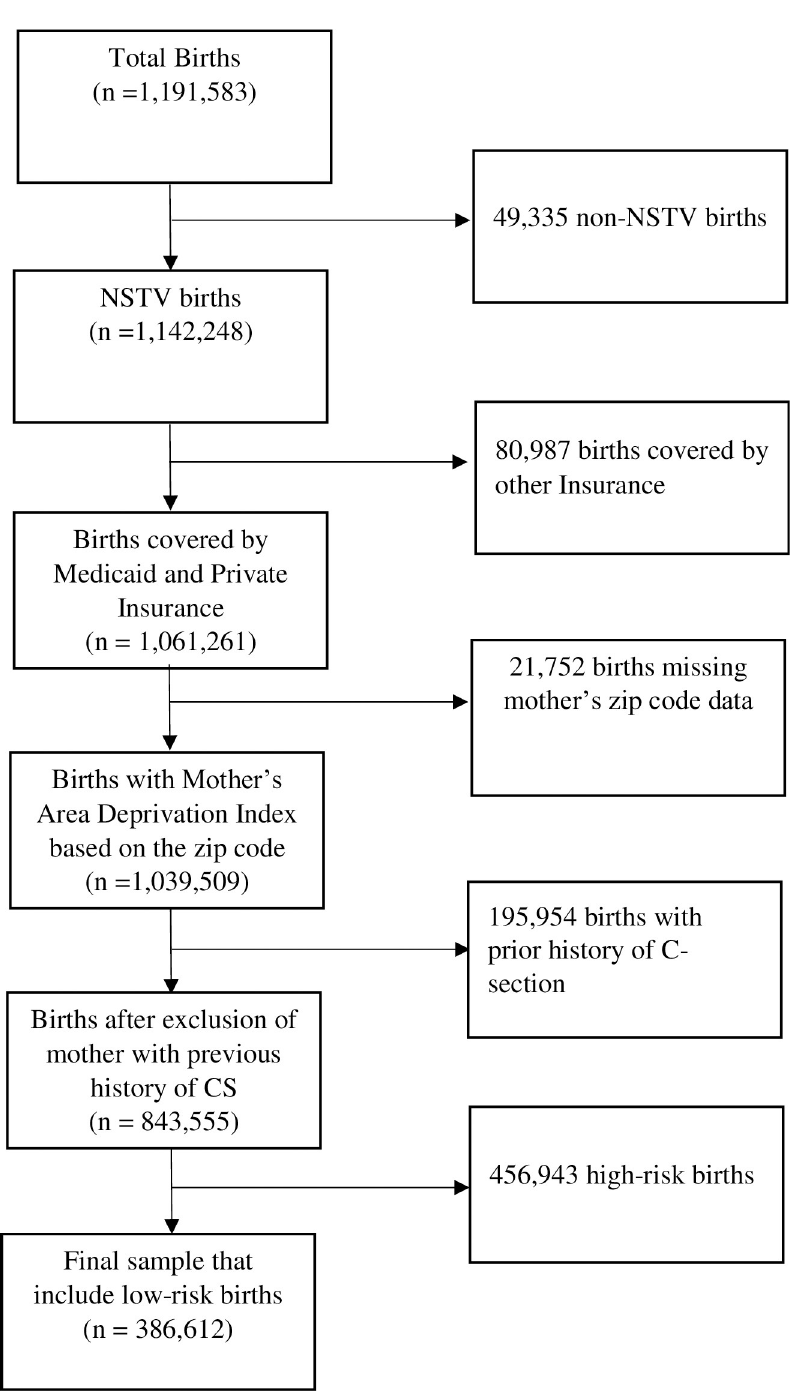
Fig 1. Flow chart for selecting the analytical sample (N =